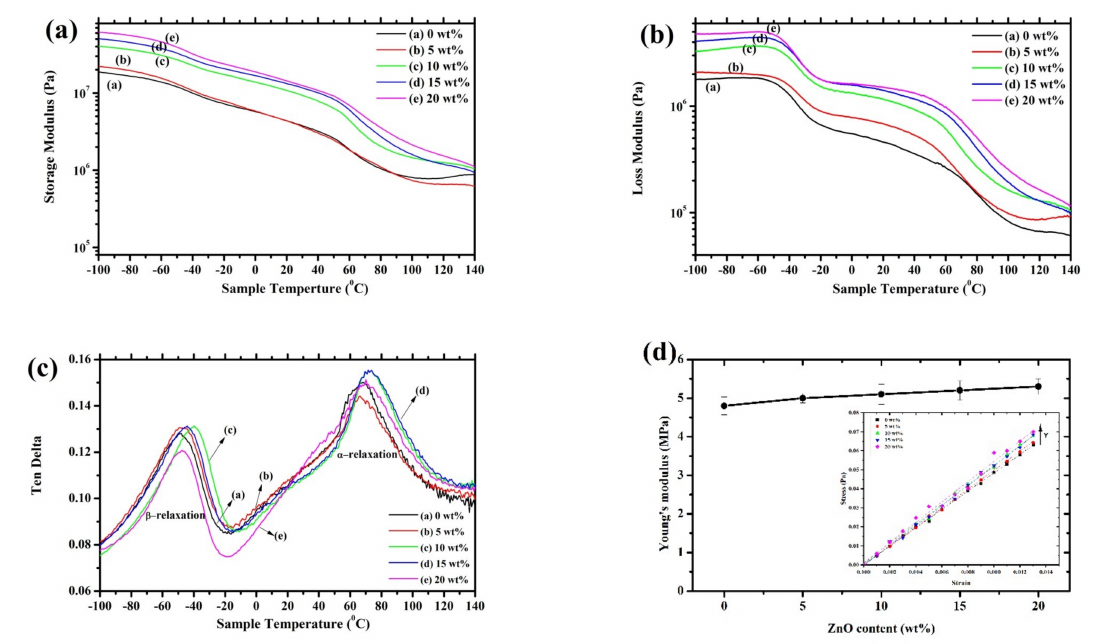
Figure 8. The dynamic mechanical analysis curves of pure P(VDF-HFP) fiber and composites fiber as a function of temperature for the ( a ) storage modulus; ( b ) loss modulus; ( c ) tan delta; and ( d ) Young’s modulus of the samples versus the weight fraction of ZnO; the slope of stress–strain curves of all samples is shown as an